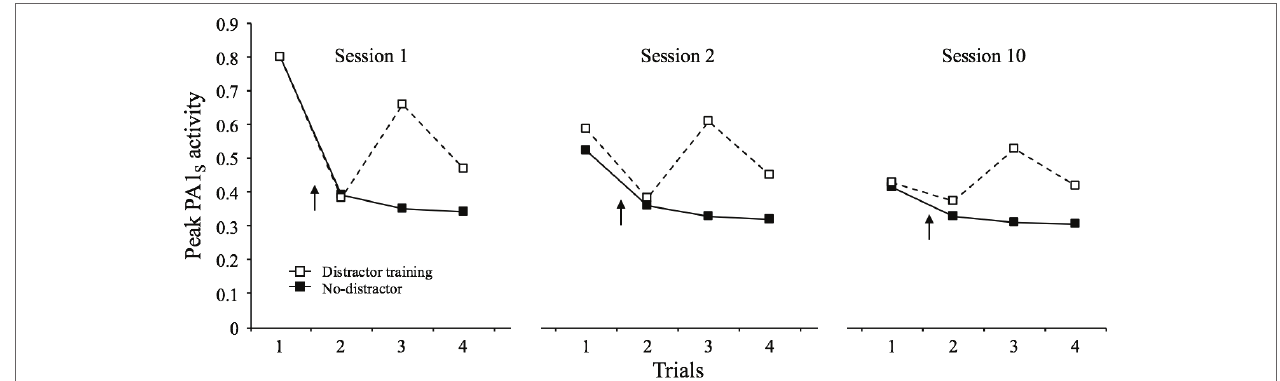
FIGURE 8 | Simulated peak PA1 S activity over 4 presentations of a 1-moment stimulus at a 32-moments inter-stimulus interval over 3 training sessions. In the distractor-training condition, a novel 1-moment stimulus ( p 1 = 0.8; pd 1 = 0.1, and pd 2 = 0.02) was presented between trial 1 and 2 of each session, while in the other condition there was no such a stimulus in any trial The arrow indicates the distractor location in each